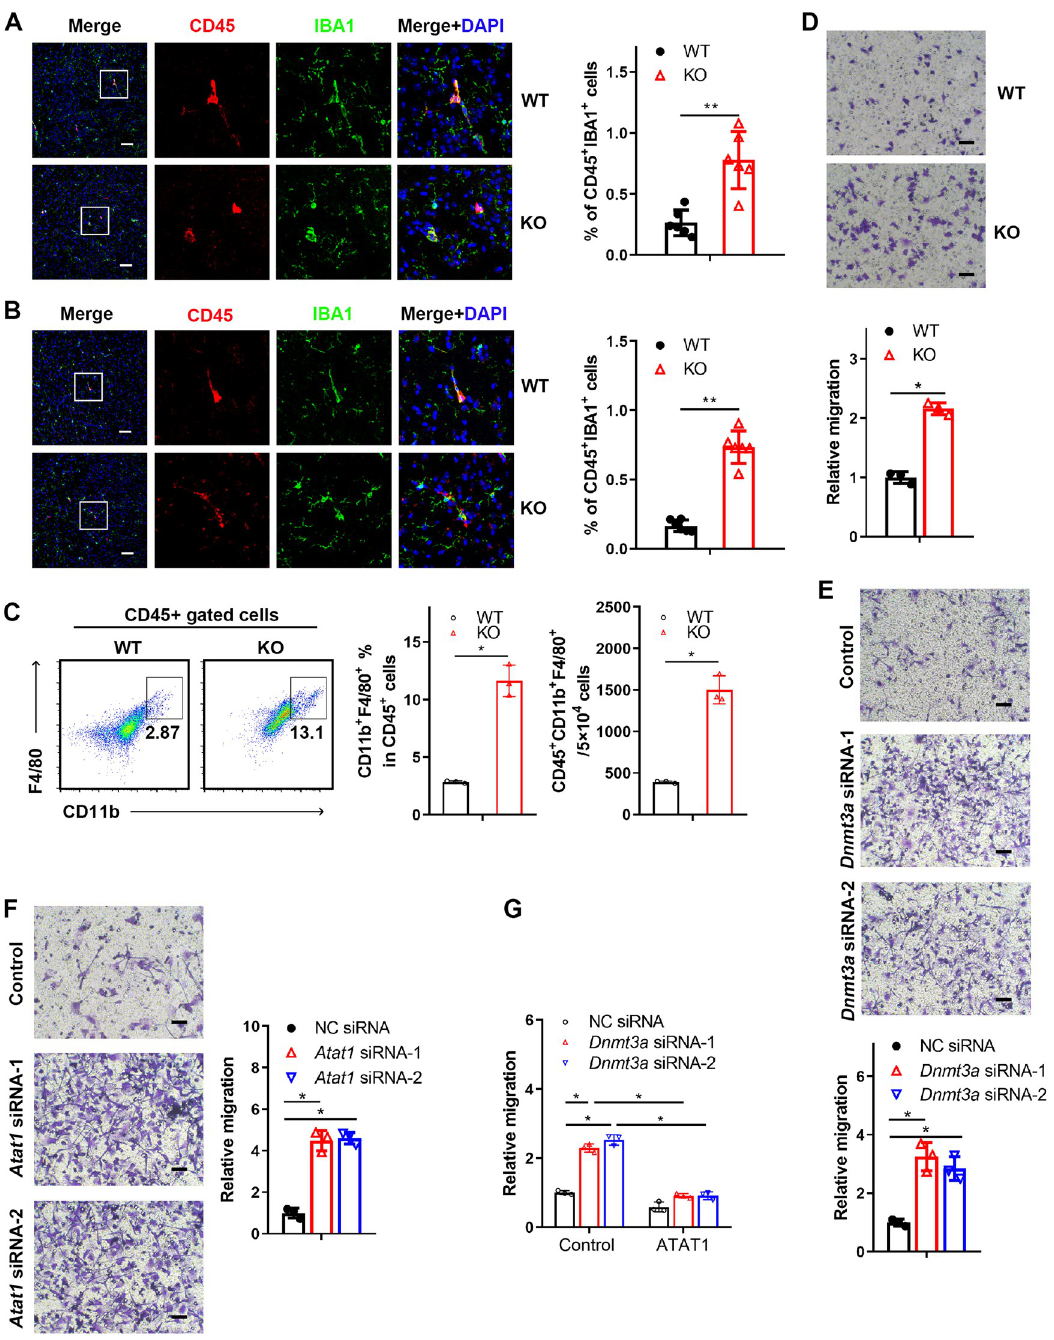
Fig 6. METTL3 inhibits the migration and infiltration of monocyte-derived macrophage into brain. (A) Colocalization of CD45 with IBA1 in the brain of A β -induced AD mice. Images are representative of 3 independent experiments. Scale bars: 50 μ m. (B) Immunofluorescence showing the colocalization of endogenous CD45 with IBA1 in the brains of 24-month-old mice. The percentage of CD45 + IBA1 + cells was quantified. Scale bars: 50 μ m. (C) Flow cytometry analysis of brains from the A β -treated WT or KO mice. (D) Cell migration in transwell assays was assessed with WT and KO BMDMs. Scale bars: 30 μ m. (E) Transwell assays were used to determine the migration of BMDMs transfected with NC siRNA or Dnmt3a siRNA. Scale bars: 30 μ m. (F) Transwell assays were performed to determine the migration of the BMDMs transfected with NC siRNA or Atat1 siRNA. Scale bars: 30 μ m. (G) Cell migration was quantified in the ATAT1-overexpressing THP1 cells transfected with NC siRNA or Dnmt3a siRNA. All data in the figure are shown as the mean ± SD. P < 0.05 ( � ), P < 0.01 ( �� ). Underlying data can be found in S1 Data. A β , amyloid beta; AD, Alzheimer’s disease; BMDM, bone marrow-derived macrophage; KO, knockout; NC, negative control; WT, wild type.